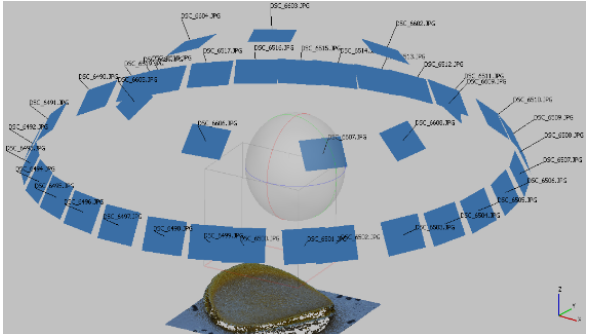
Figure 4. Image configuration using a DSLR Nikon D700 with a macro lens and a turntable (Screenshot Agisoft